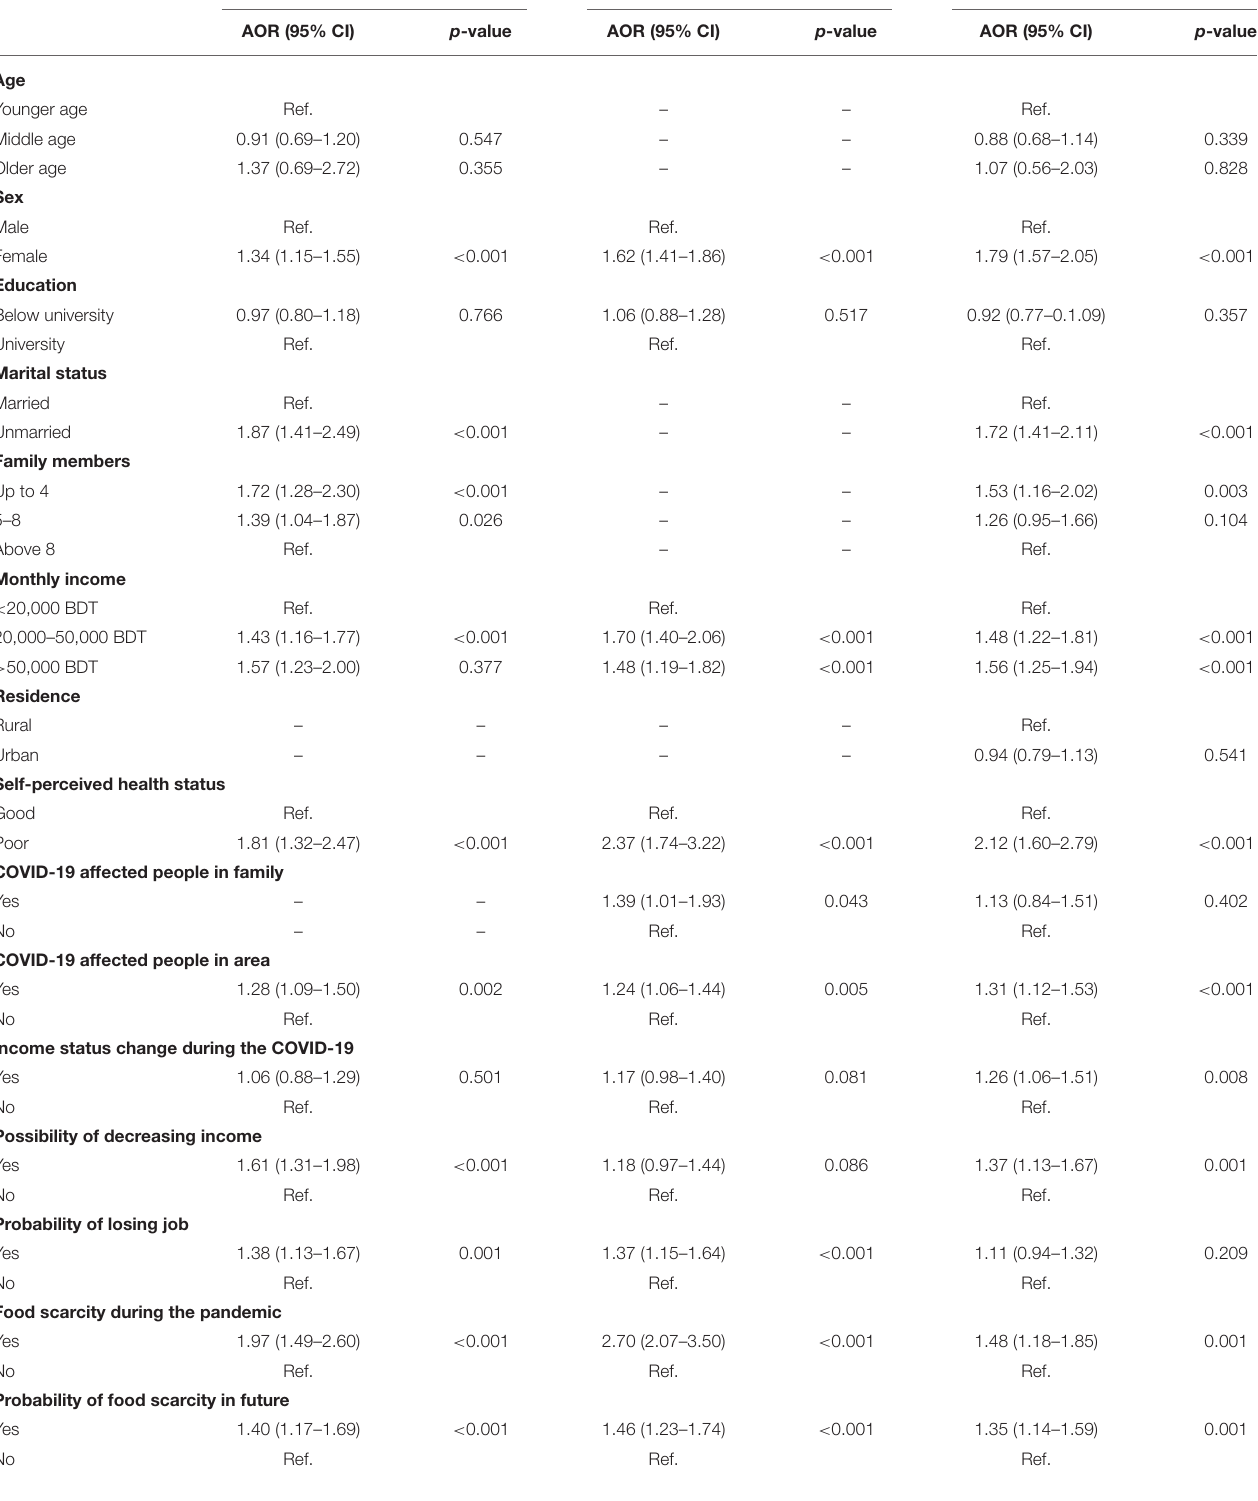
TABLE 3 | Multivariable logistic regression analysis by depression, anxiety, and